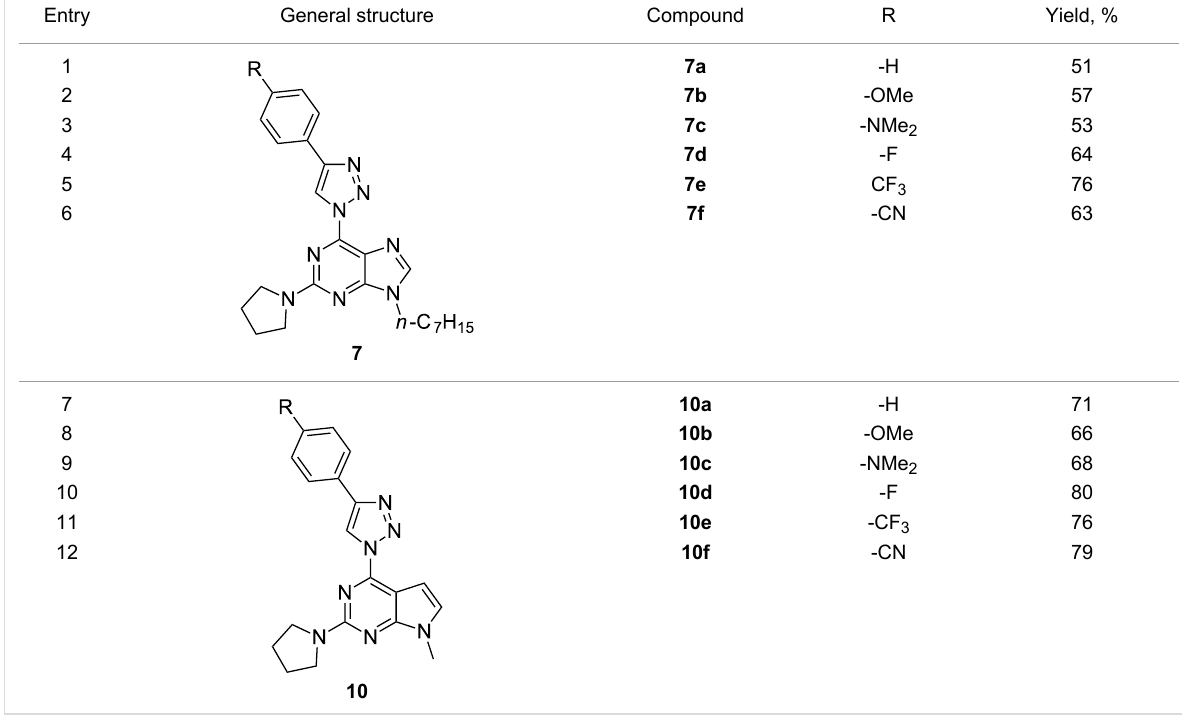
Table 1: Diversity of 9-alkyl-2-pyrrolidino-6-triazolylpurine 7 and 7-deazapurine 10 derivatives obtained in reactions 6a → 7a–f and 3 → 10a–f accord- ing to Scheme